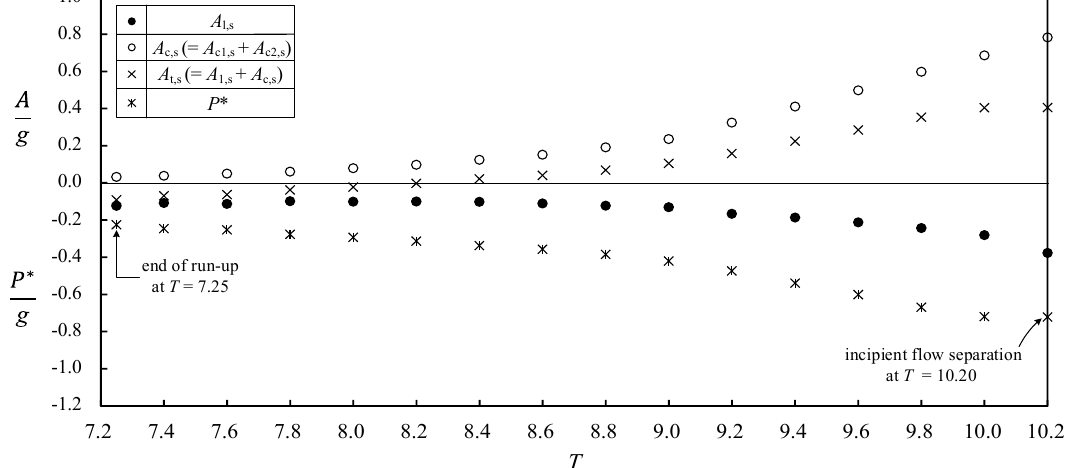
Figure 21. Variations of the smoothed values of the local acceleration A l,s , the convective acceleration A c,s , the total acceleration A t,s and the pressure gradient P * in the onshore direction at X = 18.81 cm versus the non-dimensional time, T , for 7.25 ≤ T ≤